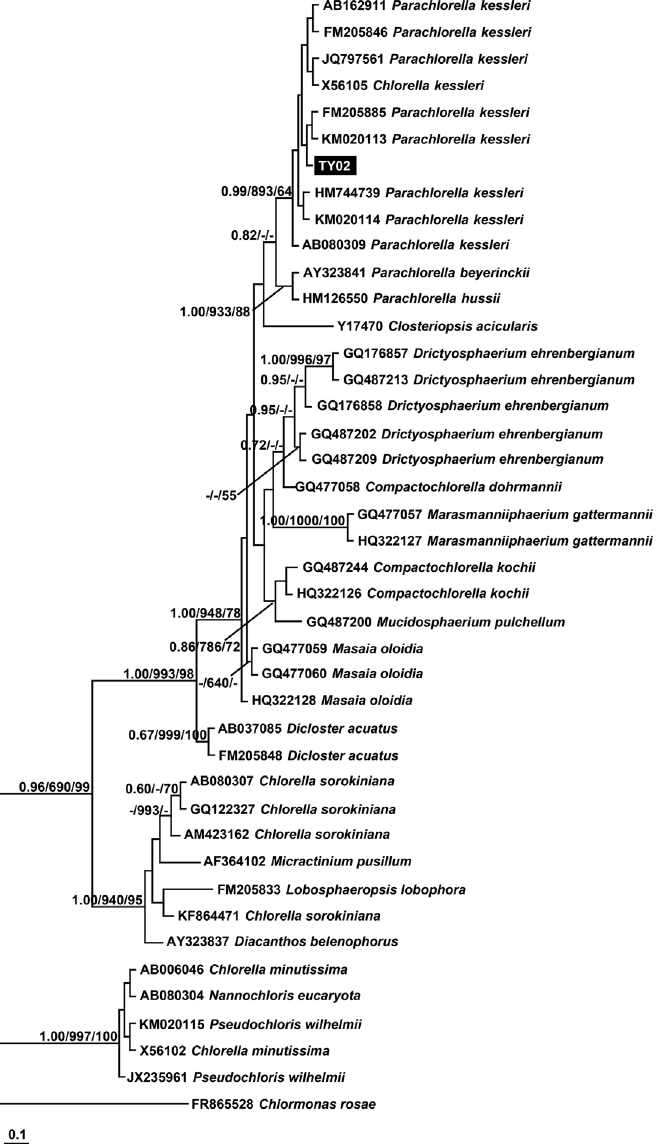
Fig. 7: Bayesian analysis tree based on 18S rDNA gene sequence. The numerical values at the nodes represent the support values of BI bootstrap/ML bootstrap/NJ bootstrap. Values <50% are not